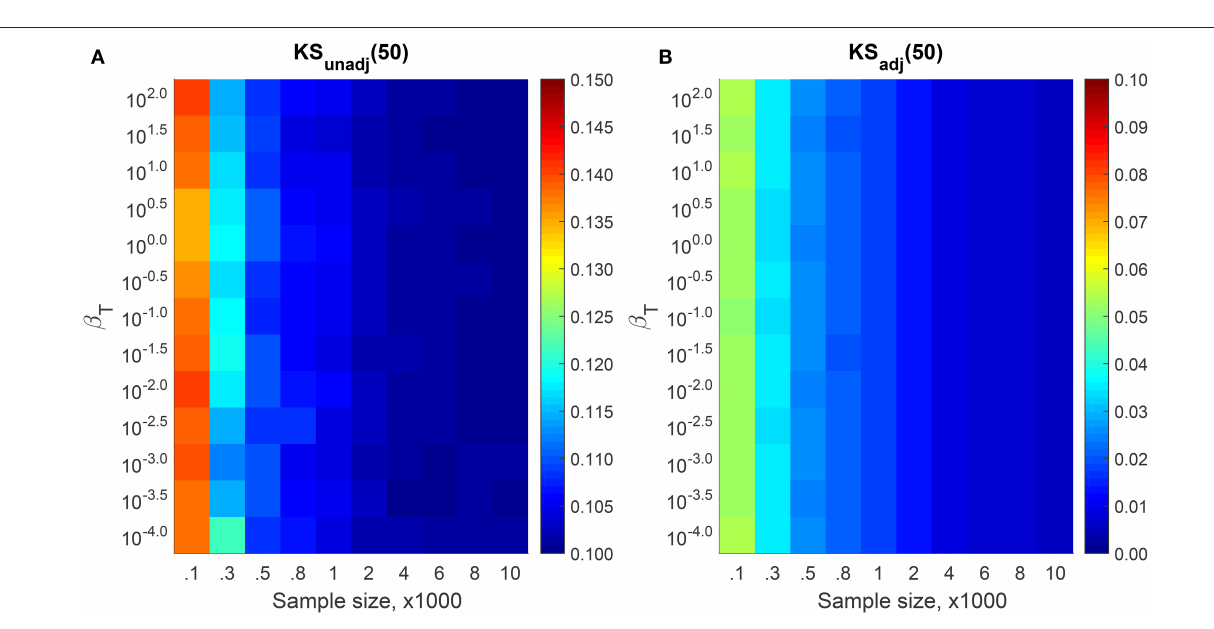
FIGURE 3 | The median KS distances for (A) KS unadj and (B) KS adj measured from 1,000 simulated samples using different β T and N . The x min is set to 0 and x max F − 1 EXP (0.9). Because of the FLE, KS unadj remains above δ =